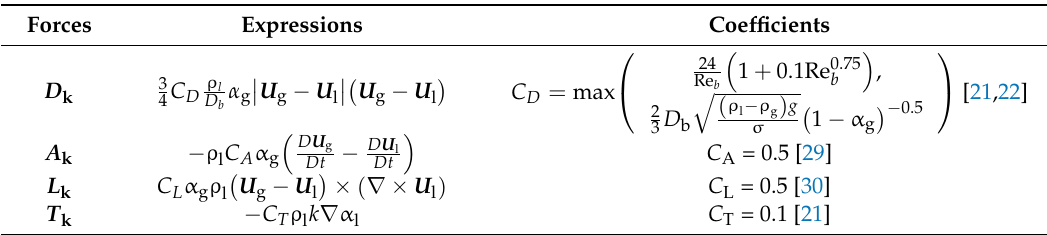
Table 2. Information on expressions of the gas-liquid interphase